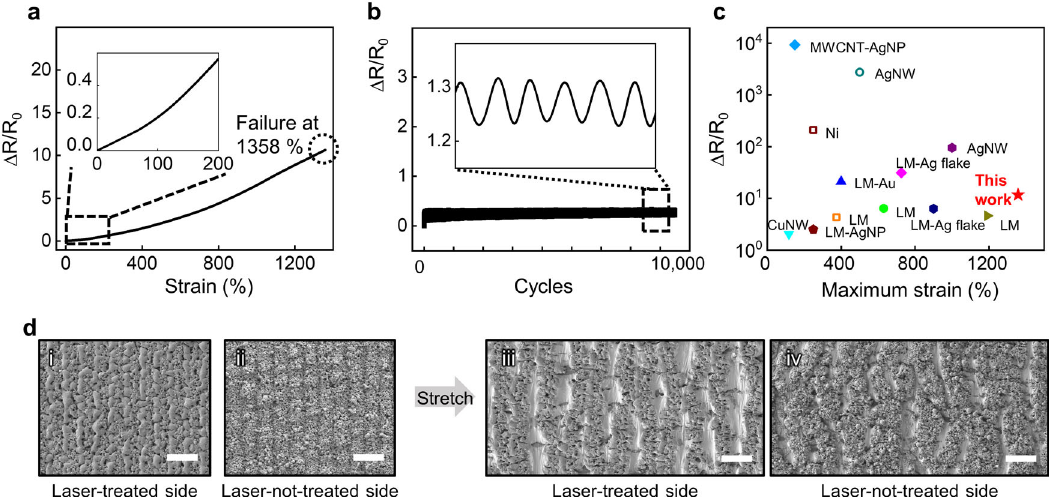
Fig. 3 Electromechanical characteristic of FS-GaIn. a Relative change in electrical resistance of FS-GaIn trace subjected to uniaxial strain with a displacement rate of 0.5 mm s − 1 . b Relative change in resistance under cyclic loading from 0% to 100% strain up to 10,000 cycles. Inset: detailed electromechanical behavior near-the end of the cyclic test c Comparison of relative resistance change at maximum strain with other thin- fi lm conductors: liquid metal 15,19,29 (LM), liquid metal and Au 30 (LM-Au), liquid metal and Ag nanoparticles 14 (LM-AgNP), liquid metal and Ag fl akes 24,31 (LM-Ag fl ake), multi-walled carbon nanotubes and Ag nanoparticles 32 (MWCNT-AgNP), Ag nanowires 33,34 (AgNW), Cu nanowires 21,35 (CuNW, Ni). d SEM images of FS-GaIn in stretching condition: (i) laser-treated side, (ii) laser not-treated side, and (iii), (iv) after stretched, respectively. Scale bars: 30 μ m ( d